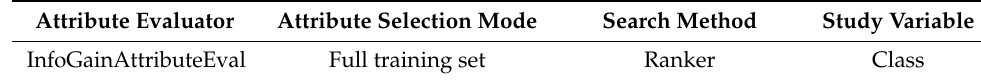
Table 3. Configuration of the first attribute evaluator.